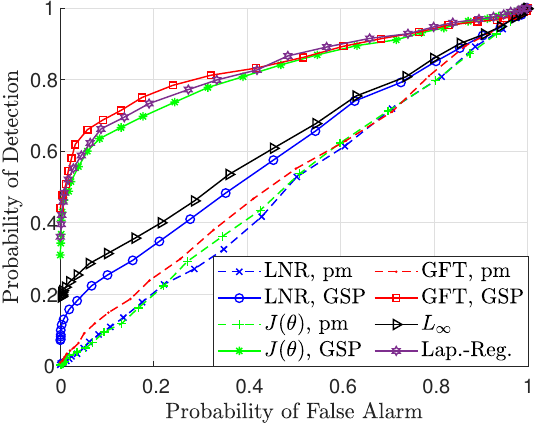
Figure 12. Bad data detection: the ROC of the LNR test (34), J ( θ ) test (35), GFT − based detector [7] implemented with the GSP − WLS (26) and (27), and the pm − WLS [11] estimators, L ∞ [69], and the Laplacian − regularized [41] detectors with q = 48